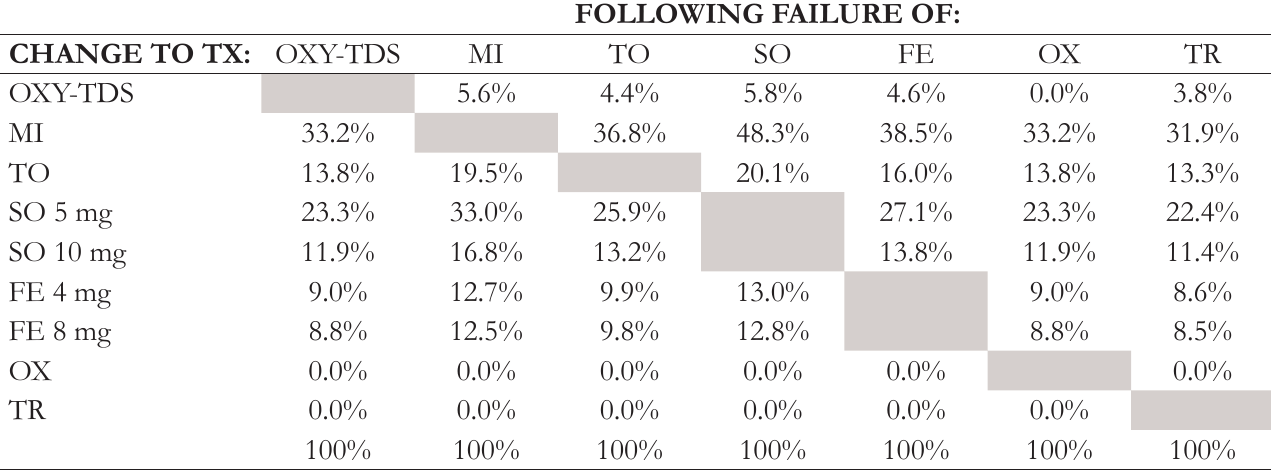
Table 2. Distribution of Treatment Prescribed Following Failure of a